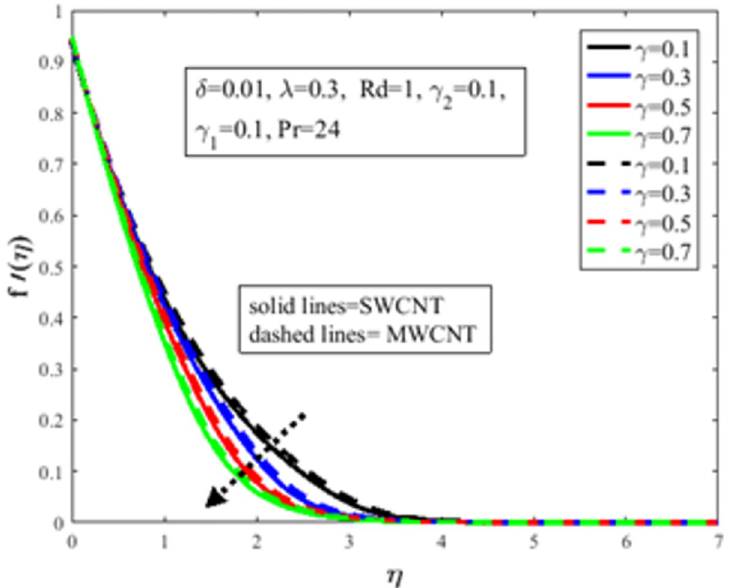
Fig 5. Effect of γ on f 0 ( η ).